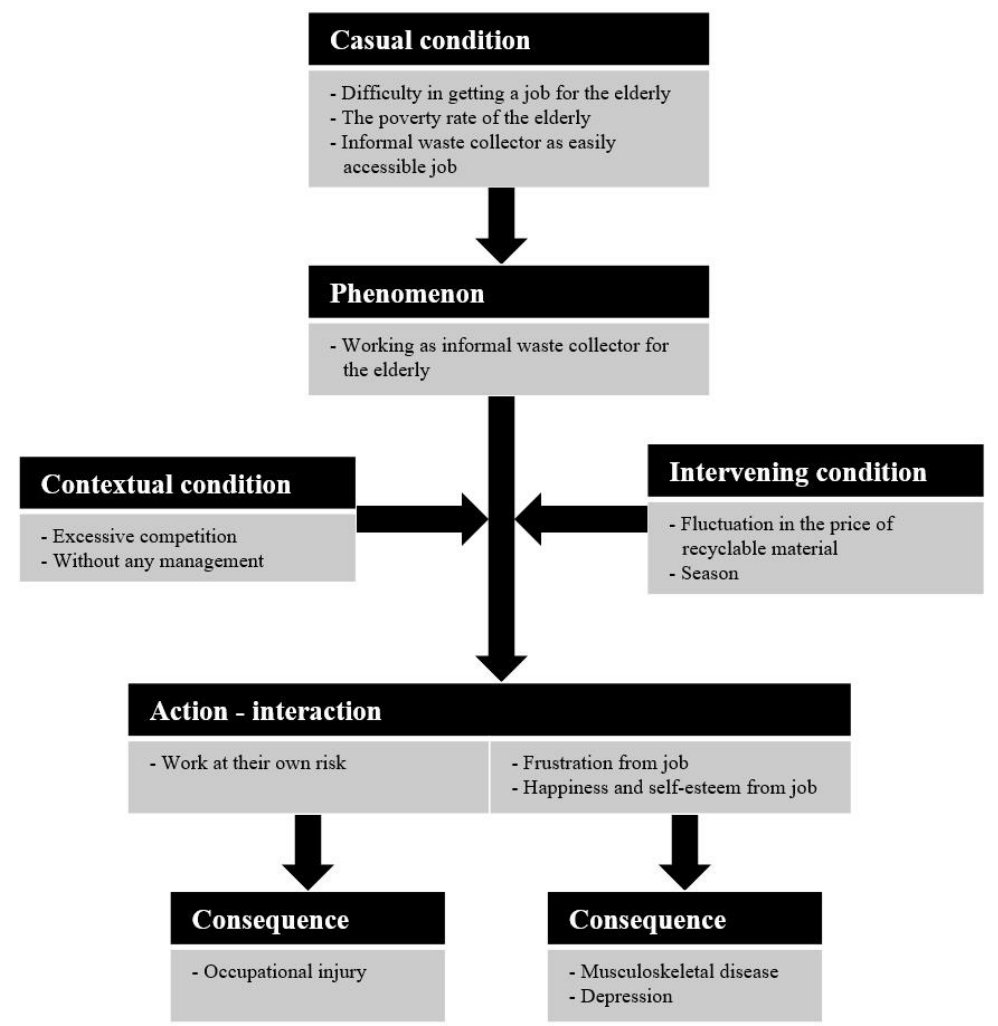
Figure 3. Conceptual model of themes and relationships.